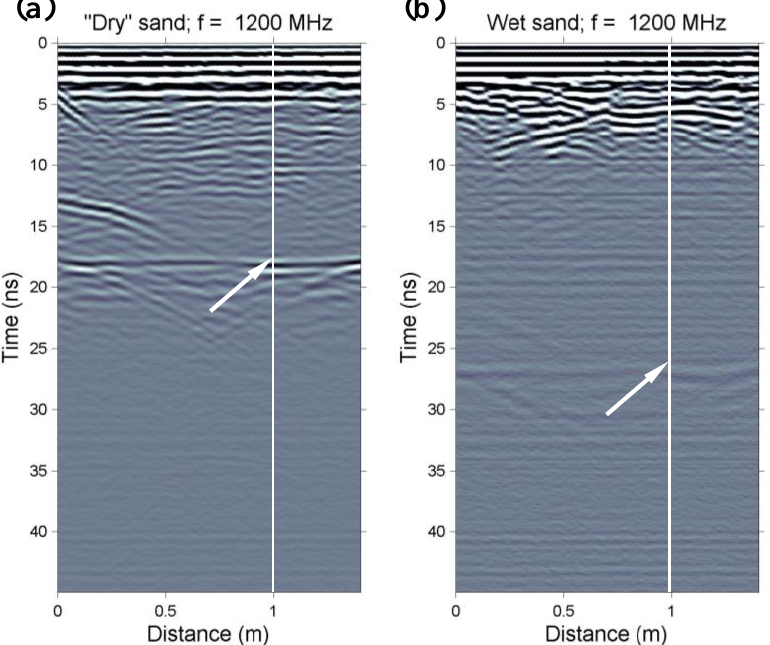
Figure 8. Two common-offset GPR profiles measured at the same location with a 1200 MHz antenna in a sandbox experiment; the sand thickness is 1 m. ( a ) for “dry” sand and ( b ) for wet sand with the water level 48 cm below the surface of the sand. The white arrow indicates the reflection coming from the bottom (at 1 m deep) of the sandbox (Author’s own work).